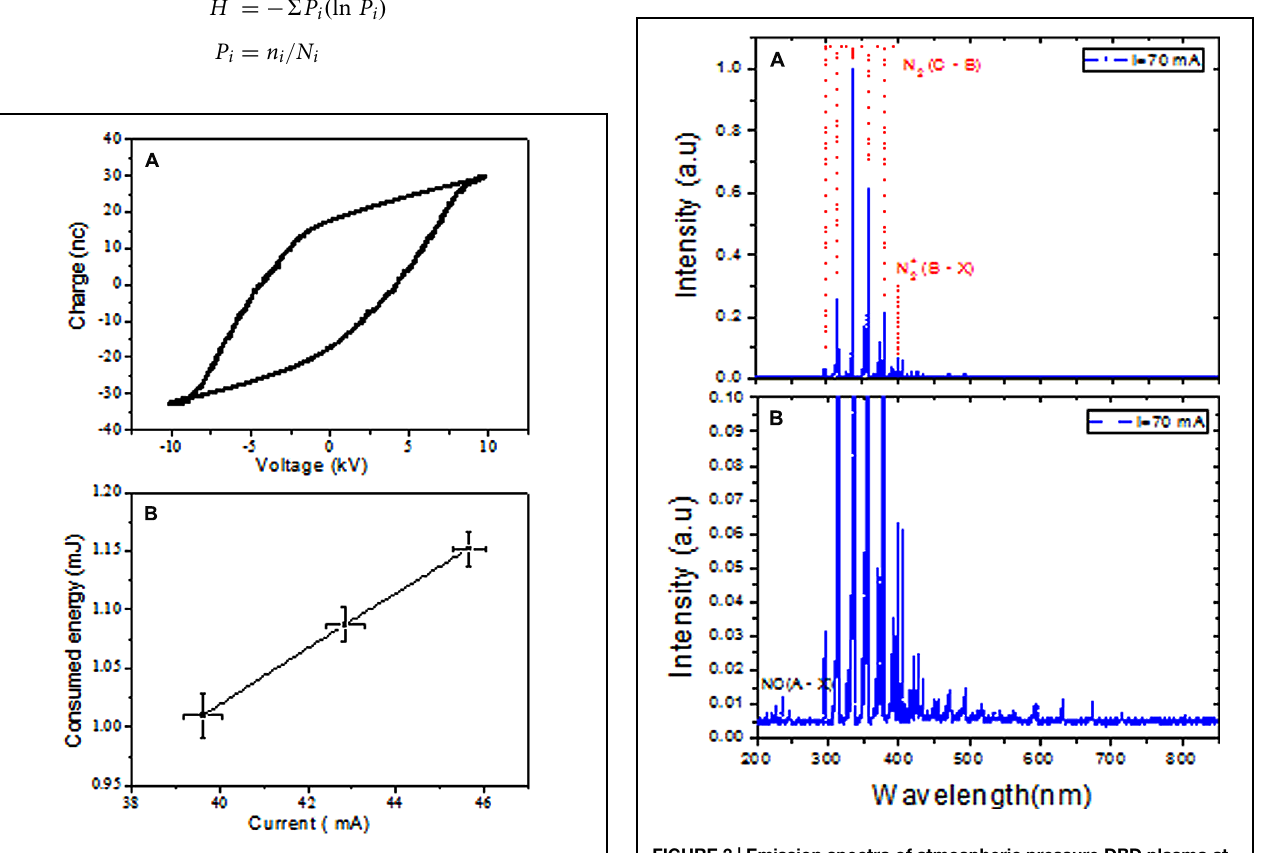
FIGURE 2 | Measurement of DBD consumed energy. (A) Example of charge – Voltage Lissajous Figure, the calculated consumed energy was 1.020 mJ at 20.24 KV and 40.35 mA peak to peak voltage and total current using 15 nF capacitance. (B) Increase in consumed energy with total current.